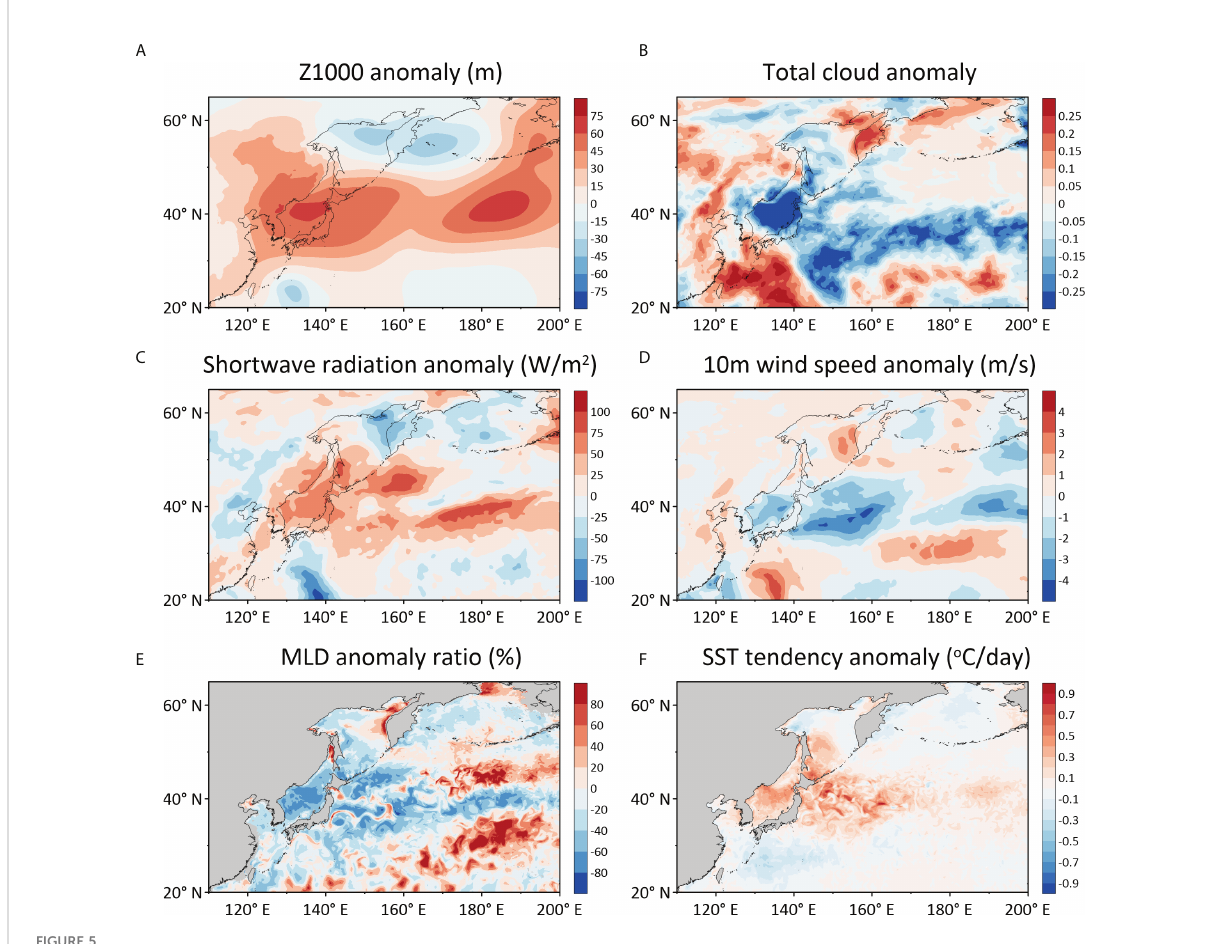
FIGURE 5 Spatial maps depicting the distribution of the (A) geopotential height at 1,000 hPa (Z1000) anomaly, (B) total cloud cover anomaly, (C) shortwave radiation anomaly, (D) 10-m wind speed anomaly, (E) ratio of the mixed-layer depth (MLD) anomaly to climatological MLD, and (F) sea surface temperature (SST) tendency anomaly during the warming period of 2021 relative to 2001 –